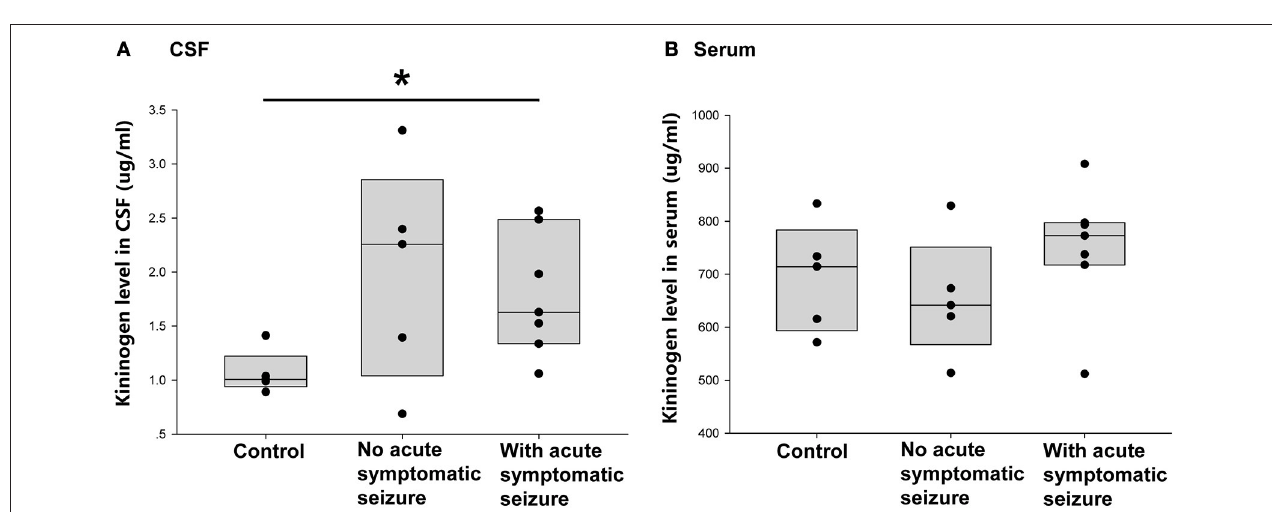
FIGURE 4 | Correlation between acute symptomatic seizure and KNG protein level in post-acute phase CSF/ serum. (A) The level of KNG in CSF of control and encephalitis patients with and without acute phase symptomatic seizure. (B) The level of KNG in serum of control and encephalitis patients with and without acute phase symptomatic seizure. * p <